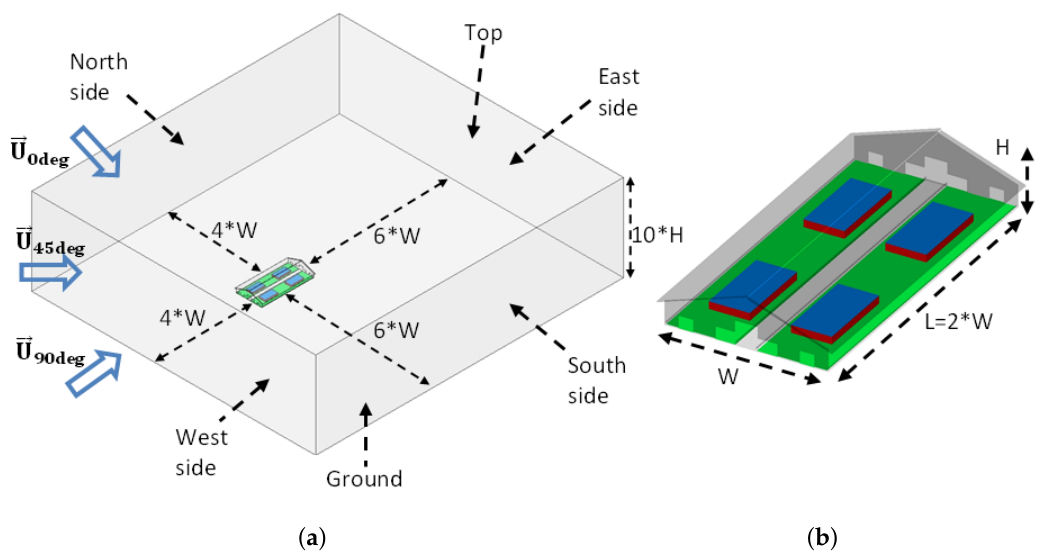
Figure 4. ( a ) Description of the domain dimensions and the three inlet flow directions; ( b ) focus on the barn dimensions and the AOZs (red), CO 2 sources (blue), and NH 3 sources